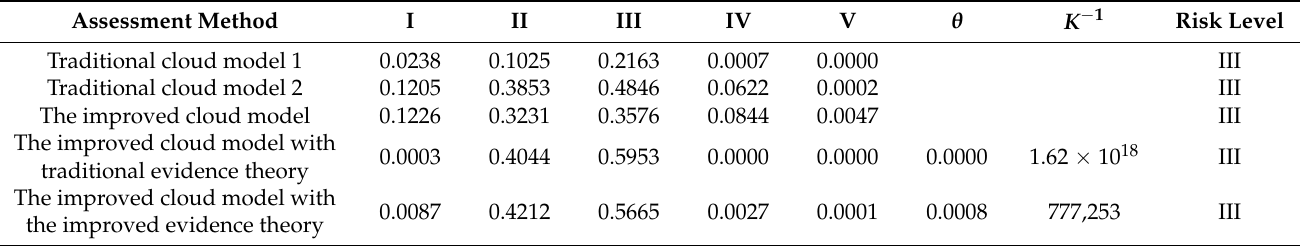
Table 6. Fire risk assessment results of the urban utility